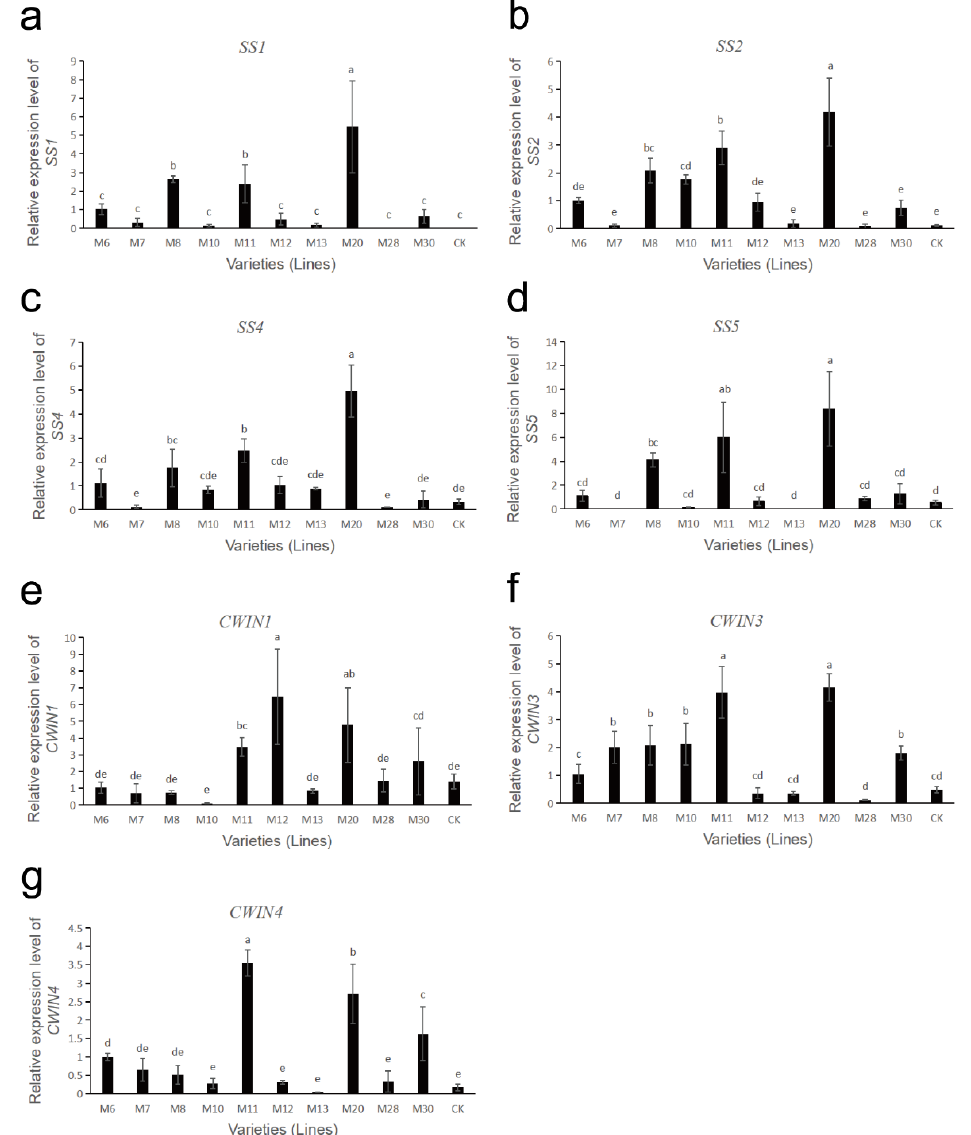
Figure 7. Expression analysis of sucrose metabolism-related enzyme genes in wild A. eriantha of different varieties (lines) at the soft ripening stage, including SS1 ( a ), SS2 ( b ), SS4 ( c ), SS5 ( d ), CWIN1 ( e ), CWIN3 ( f ) and CWIN4 ( g ). The different letters in each figure indicate significant difference ( p < 0.05), and the same letters indicate no significant difference ( p > 0.05).